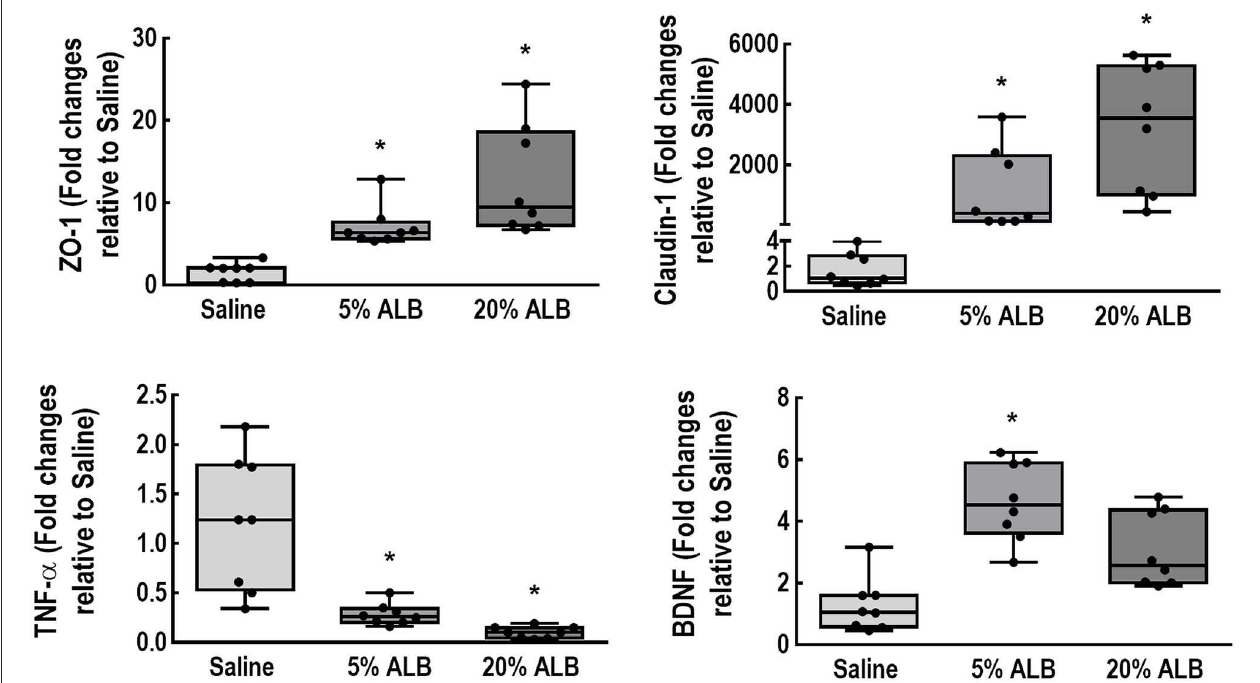
FIGURE 3 | Expression of biologic markers associated with brain damage. Real-time polymerase chain reaction analysis of biologic markers associated with blood-brain barrier integrity (zonula occludens [ZO]-1 and claudin-1), brain inflammation (tumor necrosis factor [TNF]- α ), and neurotrophic activity (brain-derived neurotrophic factor [BDNF]). Boxes show the interquartile range (25–75th percentile), while whiskers encompass the range (minimum-maximum) and horizontal lines represent the median in 8 animals/group. Scatter plots are also presented. Relative gene expression was calculated as a ratio of average expression of each gene to the reference gene ( 36B4 ) and expressed as fold change relative to Saline group. Comparisons among all groups were done using the Kruskal–Wallis test followed by Dunn’s post hoc test. * vs. Saline. For all comparisons, significance accepted at p <